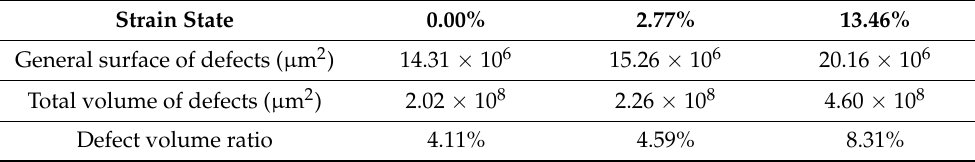
Table 2. Evolution of total internal defects under different deformation